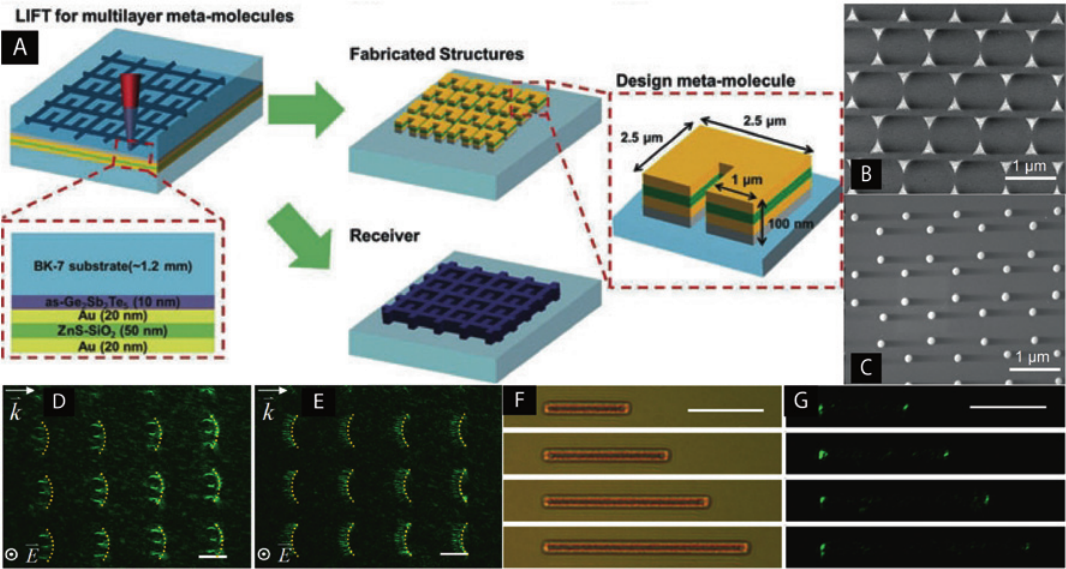
Figure 5: LIT in plasmonics and metamaterial fabrication. (A) Schematic illustrating the LIFT process for fabrication of a split ring resonator array.ReprintedwithpermissionfromRef.[70].(B-C)LIBTofasphericalgoldnanoparticlearraywithSEMimagesofthedonorsubstratebefore transfer ( B) and the receiving substrate after transfer ( C). The pattern on the donor substrate is achieved using nanosphere lithography with physical vapor deposition of a gold fi lm. Reprinted with permission from Ref. [75]. (D – E) Dark fi eld images of surface plasmon polaritons scattering by concave (D) and convex (E) nanofences composed of gold nanoparticles. The green lines seen in the images correspond to a 532 nm laser interacting in-plane with these nanostructures. Scale bars are 10 μ m. Reprinted with permission from Ref. [76]. (F – G) Optical microscope images of gold plasmonic waveguides with varying length (F) and dark- fi eld microscopy demonstrating the guiding properties of the waveguides (G). Scale bars are 10 μ m. Reprinted with permission from Ref.